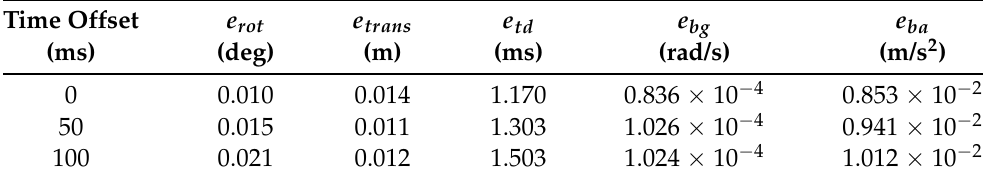
Table 1. Errors of extrinsic spatial-temporal parameters and IMU biases in the presence of all different types of IMU